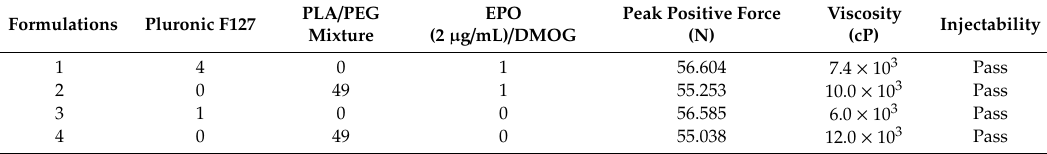
Table 1. Formulation compositions of printing inks containing PEO and DMOG ( w / w ratio).